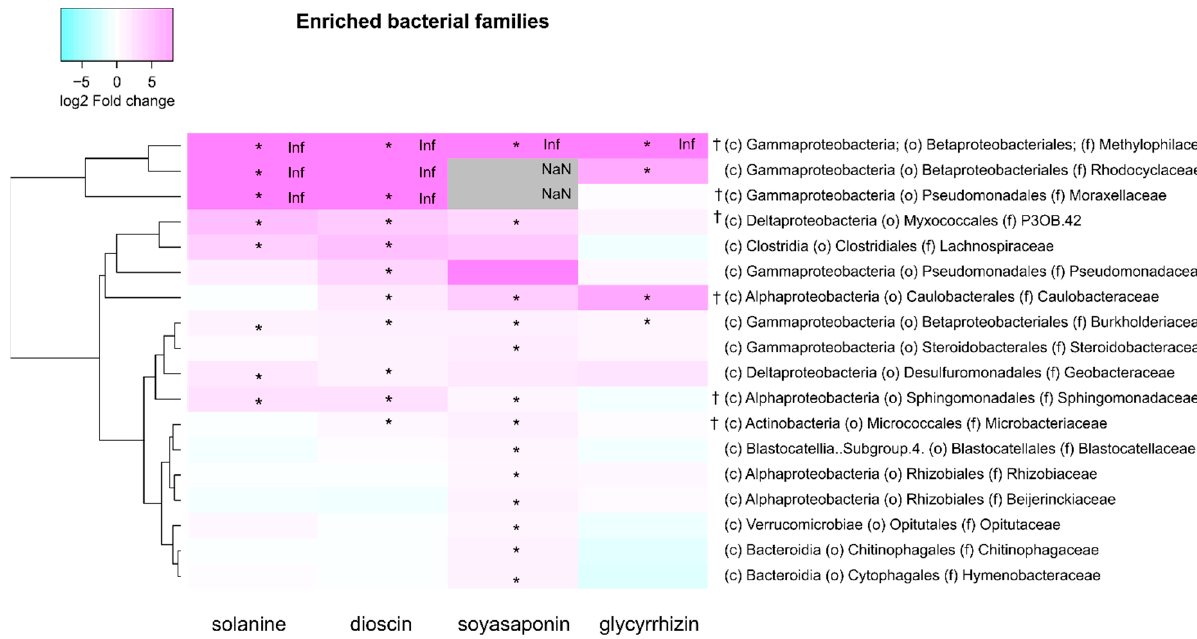
Figure 5. Clustered heatmaps showing the ratio of the relative abundances of the bacterial families (the mean of all samples >0.1%) in the saponin-treated soils to untreated soils. The color of the heatmaps indicates log2 fold changes in the relative abundances. Asterisks indicate statistically significant differences in the soils treated with saponins, 250 nmol (high concentrations) g soil − 1 using the LEfSe method (an adjusted p − value < 0.05). The daggers indicate families significantly enriched in tomatine-treated soil in previous work (Nakayasu et al., 2021). c, class; f, family; o, order; NaN; not a number; Inf, infinity (drawn by substituting eight for log2 fold changes).